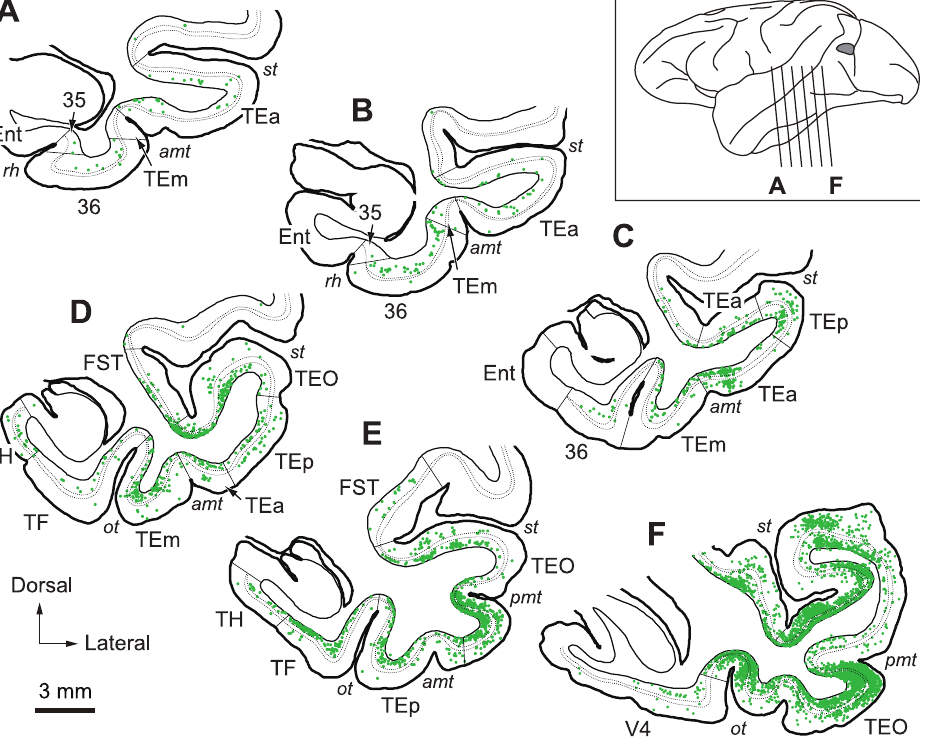
Figure 1. Distribution of retrograde labeling in the MTL 3 days after rabies injections into V4. Six representative coronal sections through the MTL in monkey V4-3a are arranged anteroposteriorly (A–F). The approximate anteroposterior levels of the sections are indicated in the lateral view of the brain (inset). The gray region represents the approximate whole extent of multiple injection sites in monkey V4-3a. Each green dot in the sections (A–F) corresponds to one labeled neuron. Dotted lines denote the borders of layer 4 in each area. amt, anterior middle temporal sulcus; Ent, entorhinal cortex; FST, fundus of the superior temporal sulcus area; ot, occipitotemporal sulcus; pmt, posterior middle temporal sulcus; rh, rhinal sulcus; st, superior temporal sulcus; TEa, anterior portion of area TE; TEm, medial portion of area TE; TEO, area TEO; TEp, posterior portion of area TE; TF, area TF; TH, area TH; 35, area 35; 36, area36.